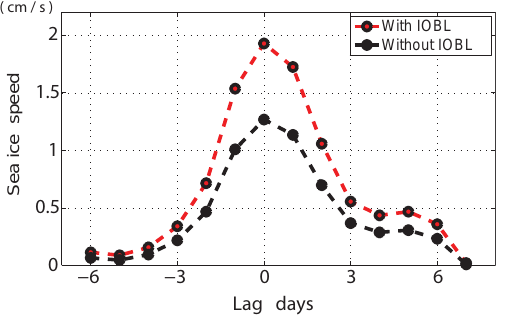
Figure 9. Lagged composite of the calculated sea ice speed (cms − 1 ) associated with the strong southerly events in the pres- ence (red line) and in the absence (black line) of an IOBL in our analytical model (in the absence of an Ekman layer the ocean sur- face velocity is simply set to 0 – the classical free drift case). The sea ice speed is area-averaged over the Pacific sector of the Arctic (from 150 to 230 ◦ E and from 70 to 90 ◦ N). The sea ice speeds include the surface Ekman layer (red line) identical to those used to construct Fig. 8. The dimensionless vertical diffusivity is set to K ∗ o = 0.028 and K ∗ o =∞ for the IOBL (red line) and no-IOBL (black line) cases,